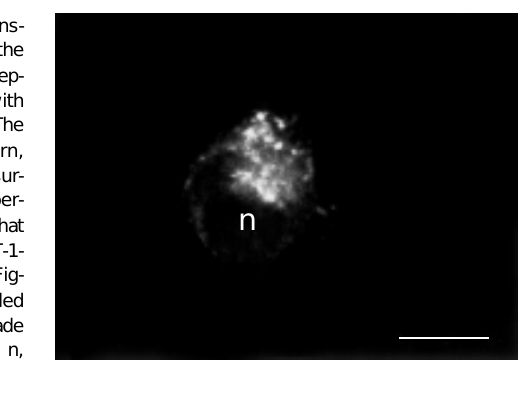
Figure 6 - Internalization of fluo- SRIF in COS-7 cells transfected with cDNA encoding the sst5 SRIF receptor. After 20 min of incubation, the bulk of the ligand is still confined to a sub-plasma- lemmal zone. Compare the dis- tribution of the acid-washable fraction of the ligand, as seen here, with that evident at the same time point in